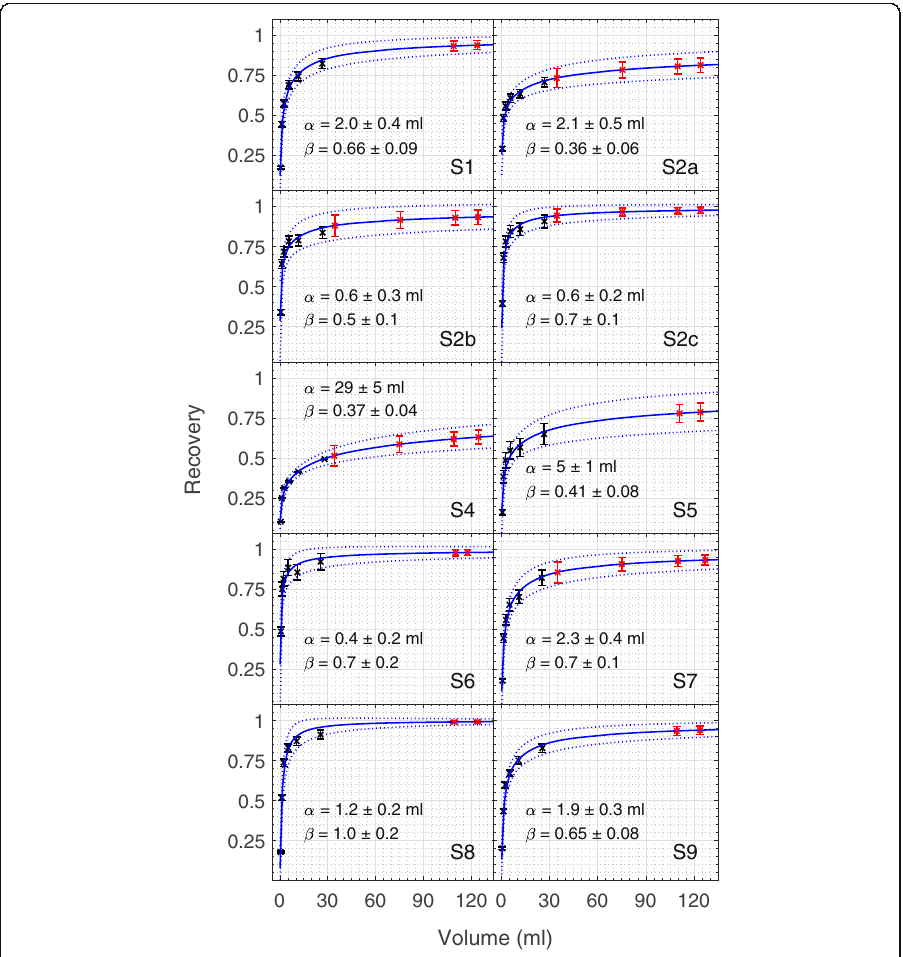
Fig. 5 Recovery curves and 95% confidence intervals fitted (to Eq. (3)) using a nonlinear weighted model for the calculated NEMA spheres recovery coefficients (black). The fitted recovery coefficients calculated for the validation data are shown in